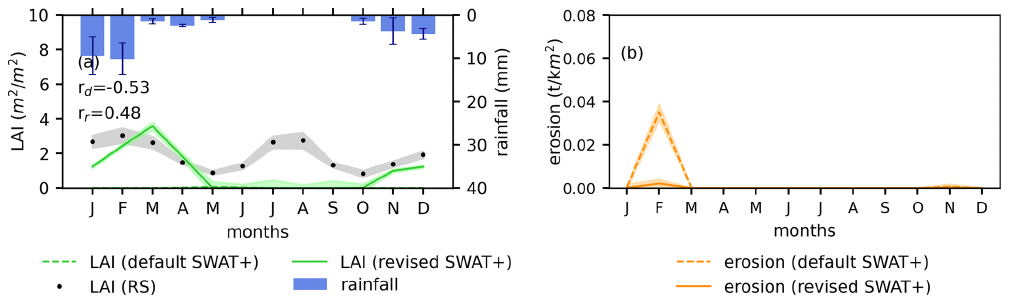
Figure 8. Monthly mean and standard deviation (bands) of LAI (a) and erosion (b) comparison for irrigated wheat in the Nile delta. The LAI correlation coefficients ( r d for the default SWAT + model and r r for the revised SWAT + model) are shown.